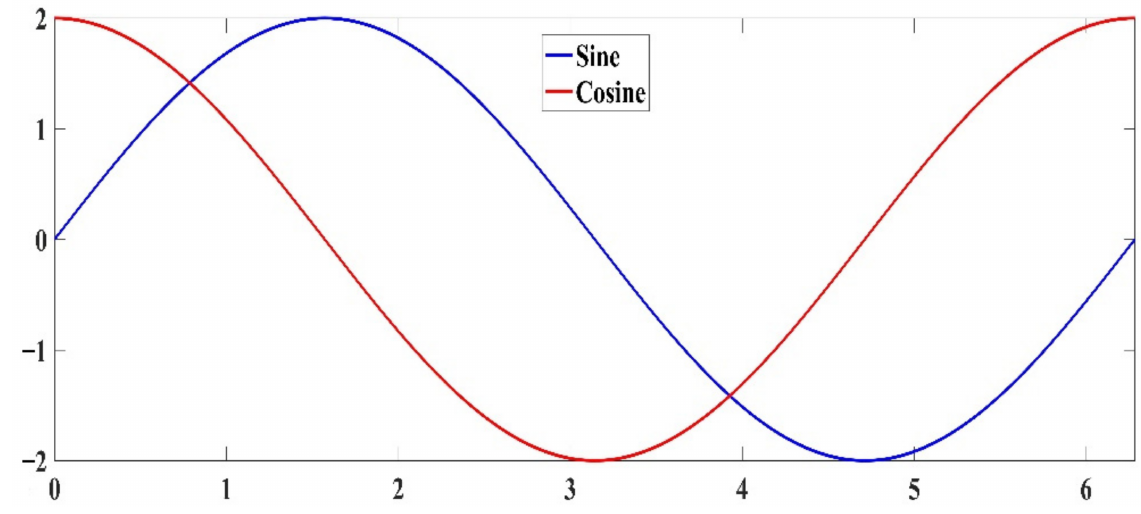
Figure 5. Cosine and sine with an amplitude scale of ( − 2, 2) and period range of {0, 2 π